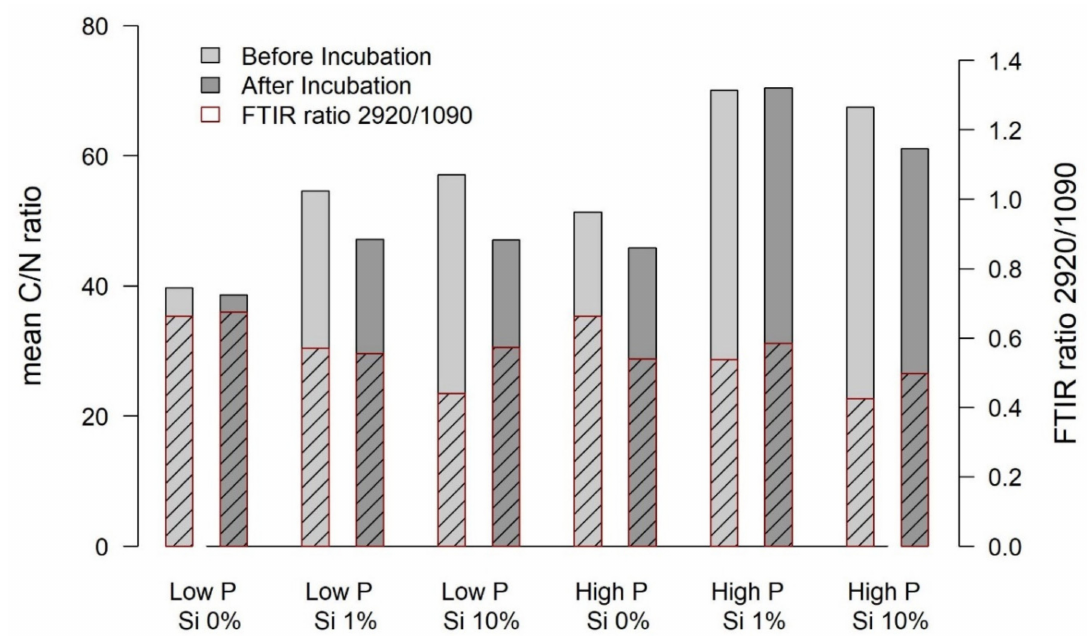
Figure 5. Mean values of the C/N ratios of biomass of Eriophorum shoots before and after the incubation (left y -axis). The hatched area denotes the FTIR ratio 2920/1090 (indicative for aliphatic structures; waxes and lipids) before and after the incubation—referring to the right